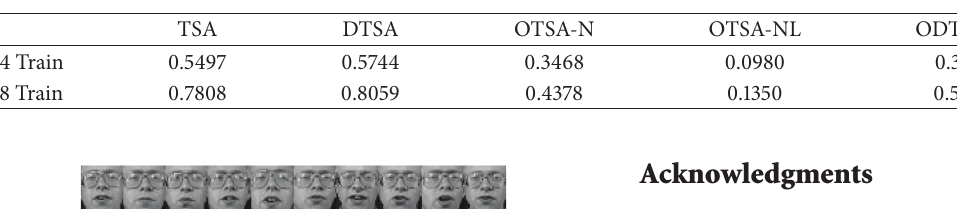
Figure 1: Sample images for one individual of the ORL database.